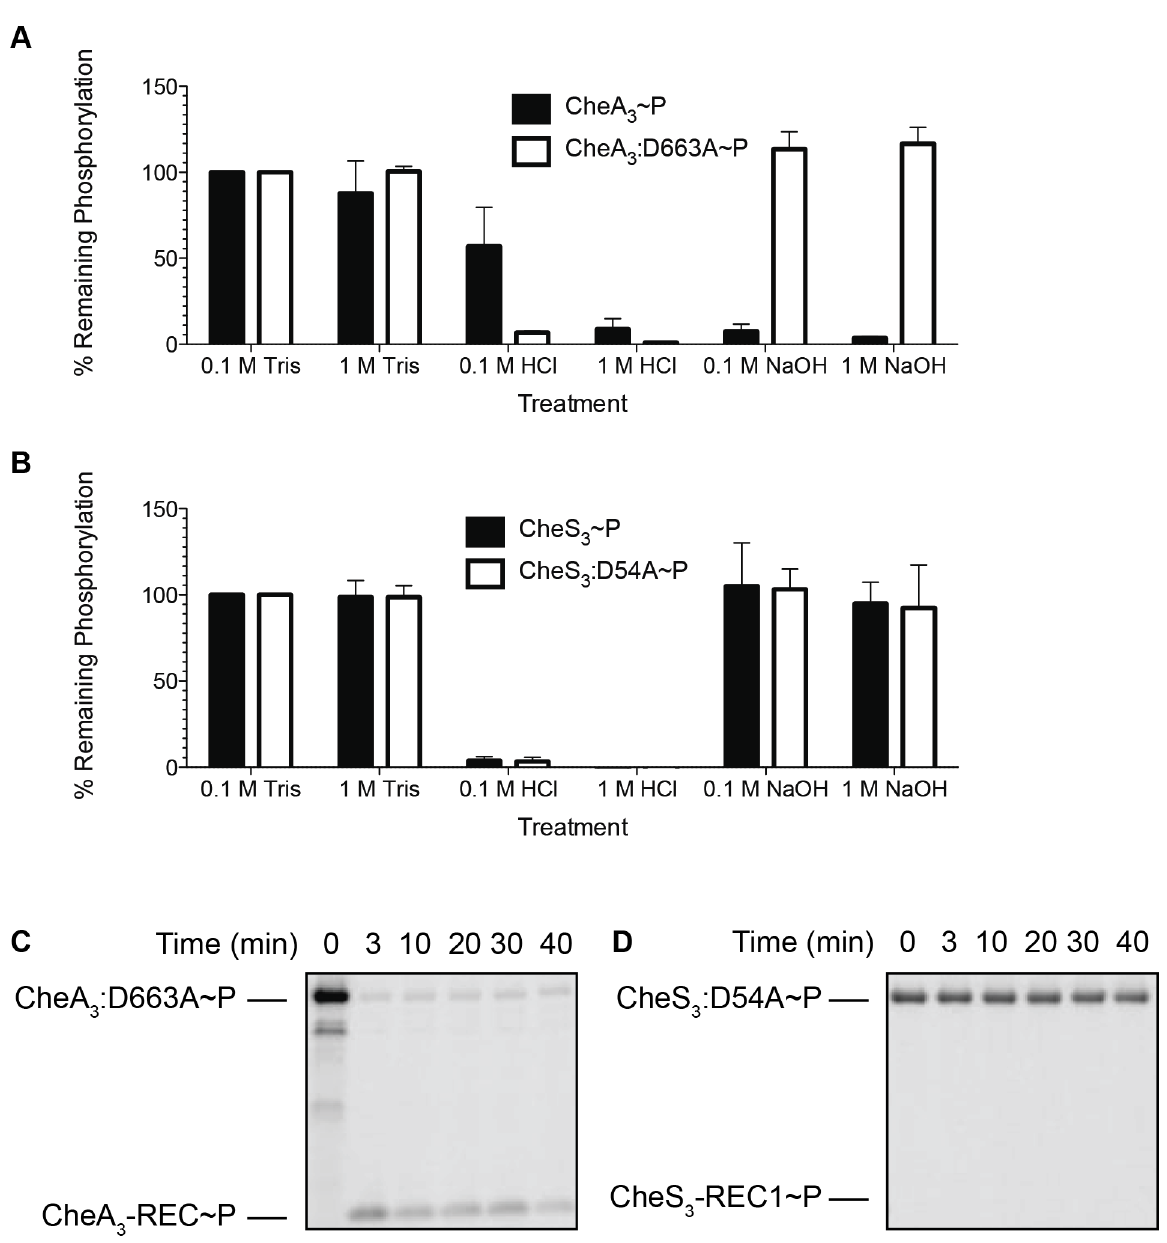
Figure 4. Identification of intramolecular phosphoryl transfer within CheA 3 and CheS 3 . (A) CheA 3 , P is acid- and alkaline-labile, whereas the REC mutant CheA 3 :D663A , P is acid-labile and base-resistant. (B) Both CheS 3 , P and its REC mutant CheS 3 :D54A are acid-labile and alkaline- stable. (C) CheA 3 :D663A , P phosphorylates CheA 3 -REC truncation protein in Buffer 15 containing K + and 18 mM Mg 2 + . (D) Phosphoryl transfer from